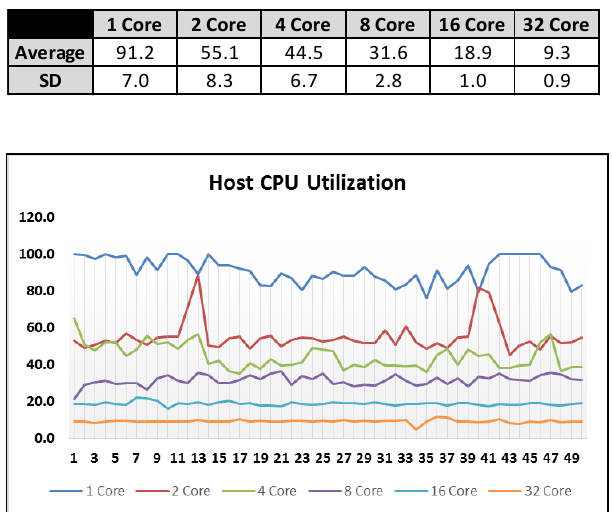
Figure 3: Intel Prototype Host CPU Utilization